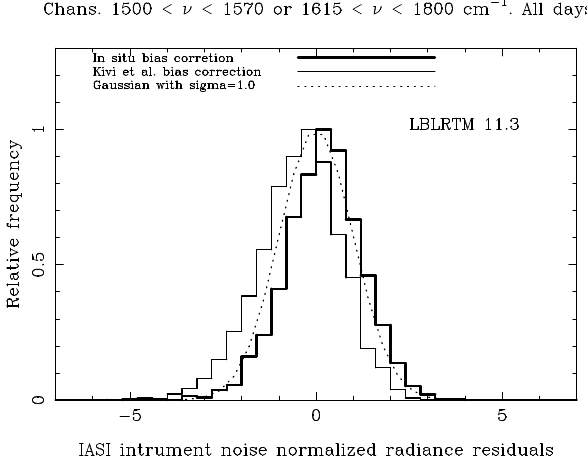
Fig. 11. Histogram of the residual radiances, IASI observed mi- nus calculated with LBLRTM 11.6 RTM and time interpolated pro- files, for all clear days (4) in the spectral range, 1500cm − 1 ≤ ν ≤ 1570cm − 1 and 1615cm − 1 ≤ ν ≤ 1800cm − 1 . One set of interpo- lated profile have been derived from the CFH sonde launched 1h before IASI overpass and the “in situ” bias corrected RS92 sonde launched 5min before satellite overpass (thick solid line). The other set of interpolated profiles have been derived from the CFH sonde launched 1h before IASI overpass and the Kivi et al. bias cor- rected RS92 sonde launched 5min before satellite overpass (thin solid line). For reference, a Gaussian curve with a σ of 1.0 is shown (dotted